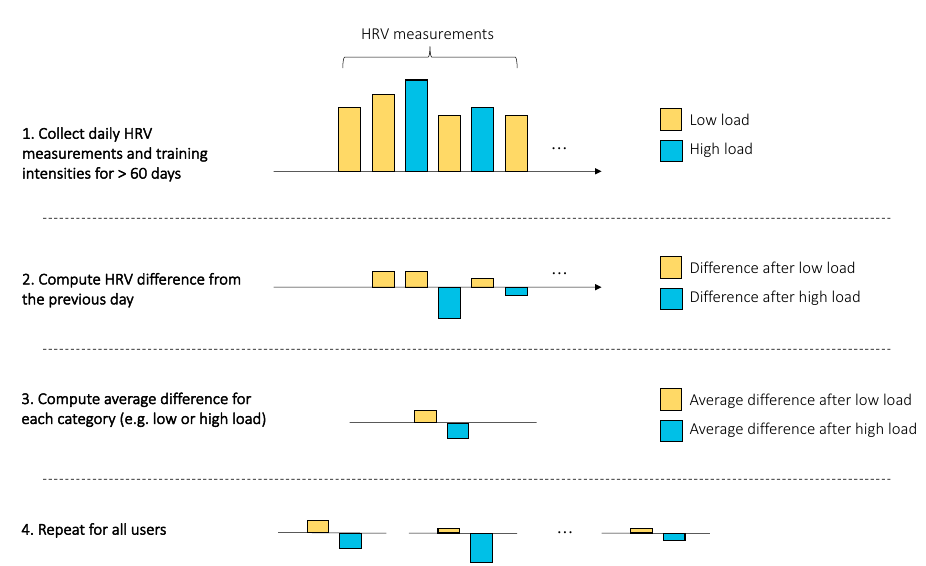
Figure 2. Procedure used for the analysis of acute stressors. First, HRV (and resting heart rate) data and annotated training intensities were collected. Then, day-to-day differences in HRV (and resting heart rate) were computed. Differences were then averaged across categories, e.g., to compute the average day-to-day change in HRV (or heart rate) in response to either easy or high training intensity. The procedure is repeated for each individual so that we can determine the stress response for each stressor at the population